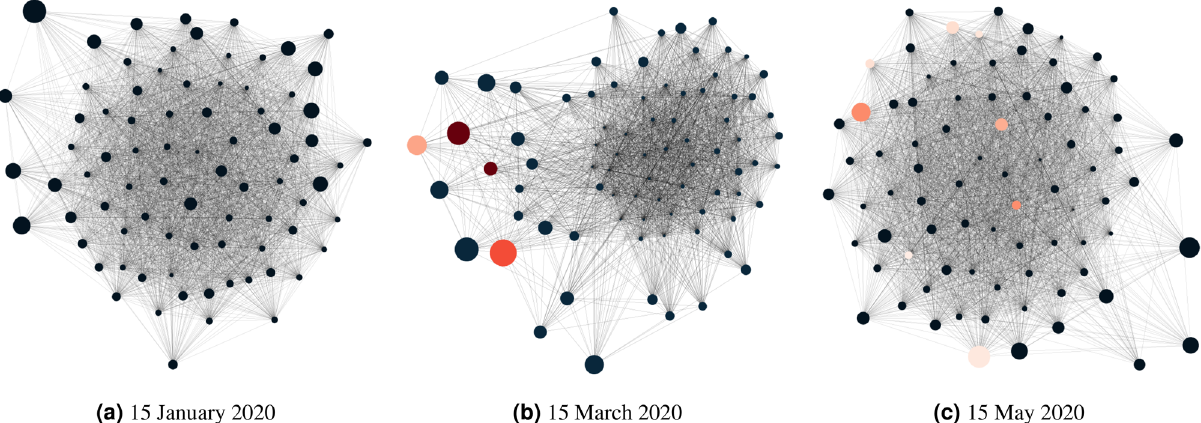
Figure 2. Network graphs at three different dates. Node size represents topic importance, which is proportional to the number the tokens generated by the topic across the whole corpus. For example, a size of 0.2 represents that an estimated 20% of tokens was covered by the chosen topic i . If the topic is coronavirus -related, its node will be represented by a red gradient, whose colour is mapped to the range between 0 and 0.1 according to the word-topic probability for coronavirus in β it